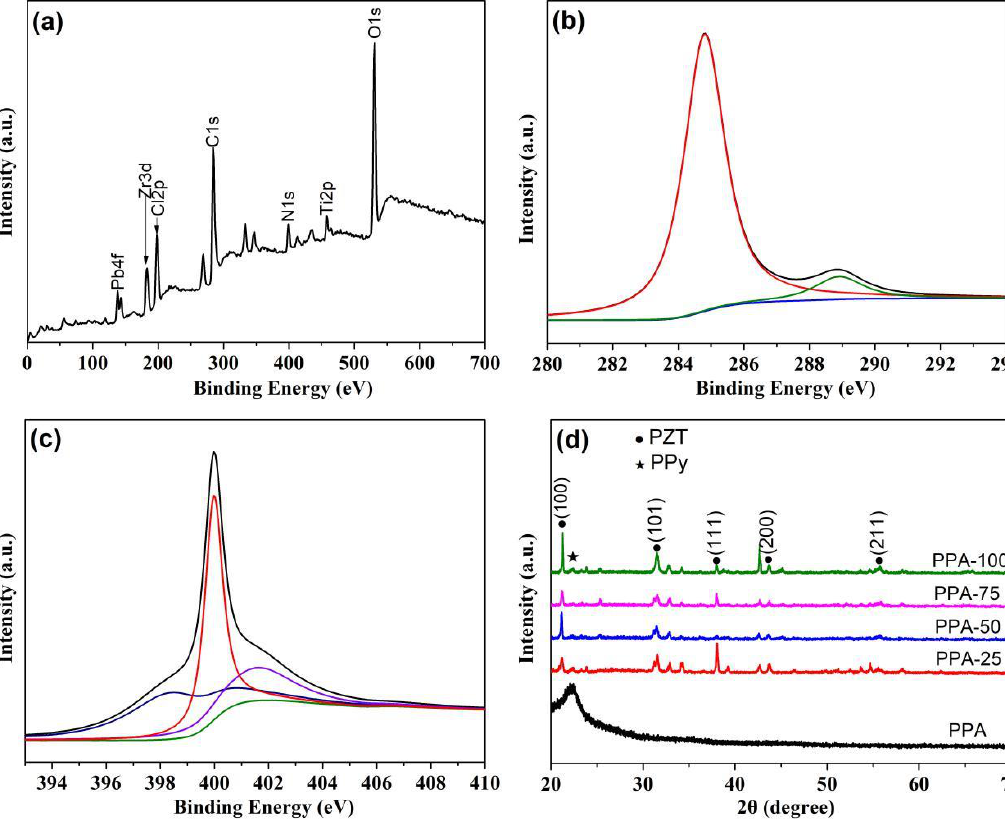
Figure 5. ( a ) Full XPS spectrum, ( b ) C 1s and ( c ) N 1s XPS core-level spectra of PPA-75; ( d ) XRD spectra of PPy and PPAs with different content of PZT ceramics.